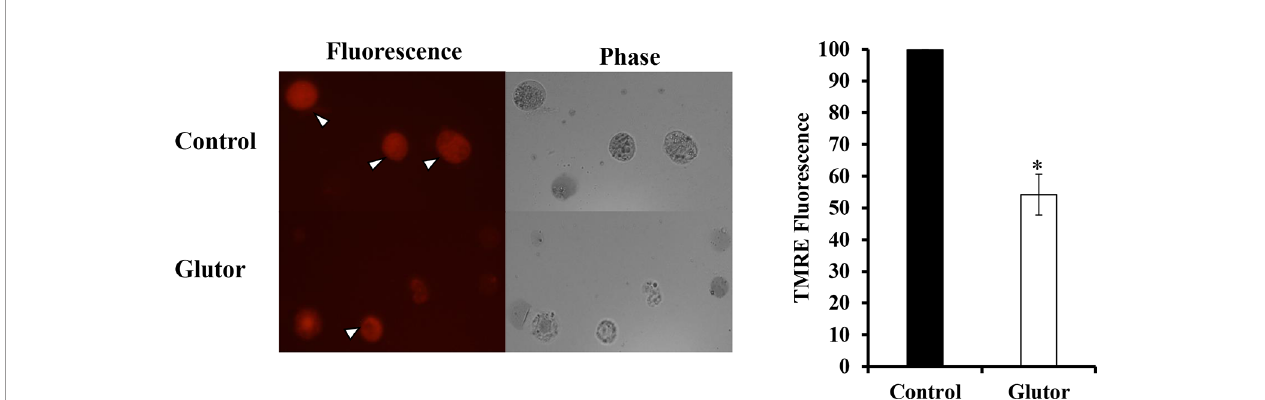
FIGURE 6 | Glutor alters mitochondrial membrane potential. DL cells (1 × 10 5 ) were incubated in a medium alone or containing glutor (0.01 µM) for 24 h, followed by TMRE staining as described in the Materials and Methods section. The plates shown are from a representative experiment out of at least two experiments with similar results. Values shown in the accompanying diagram are the mean ± SD of the fl uorescence intensity. * p < 0.05 vs.